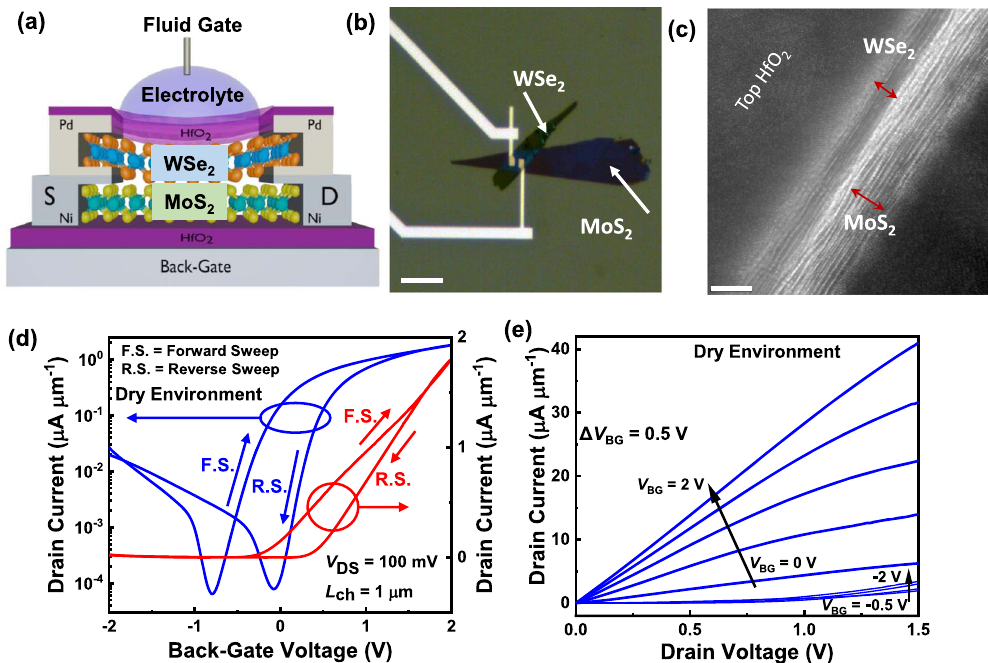
Fig. 1 Device structure and dry electrical characteristics. a Schematic of the WSe 2 (top)/MoS 2 (bottom) ISFET device, b optical image, showing the WSe 2 on MoS 2 along with the metal contacts (scale bar 10 μ m), c HR-TEM of the channel region of HfO 2 /WSe 2 (top)/ MoS 2 (bottom)/HfO 2 stack (scale bar 5 nm), and d transfer and e output characteristics of the ISFET measured in the dry